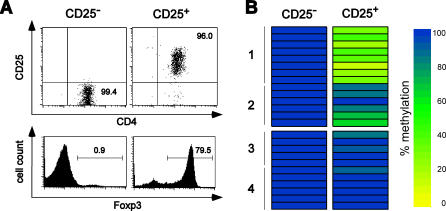
Demethylated CpG Motifs within the foxp3 Locus in CD25+ CD4 SP Thymocytes(A) CD25+CD4+CD8− and CD25−CD4+CD8− subsets were sorted from thymocytes pooled from 30 male BALB/c mice. FACS analysis shows purity of sorted subsets (upper panel) and Foxp3 expression in gated CD25− and CD25+ subsets of CD4+ SP thymocytes (lower panel). Numbers display frequency of cells within indicated populations. The bars in the lower graphs indicate the marker gate for Foxp3+ cells. The vertical and horizontal lines in the upper graphs indicate the quadrant used to identify the CD4+CD25+/− subsets.(B) Methylation pattern of selected amplicons of the foxp3 locus in CD25+ and CD25− CD4 SP thymocytes. The methylation status of individual CpG motifs within the four amplicons is color coded as described in Figure 2. One representative experiment out of two individual experiments is shown.